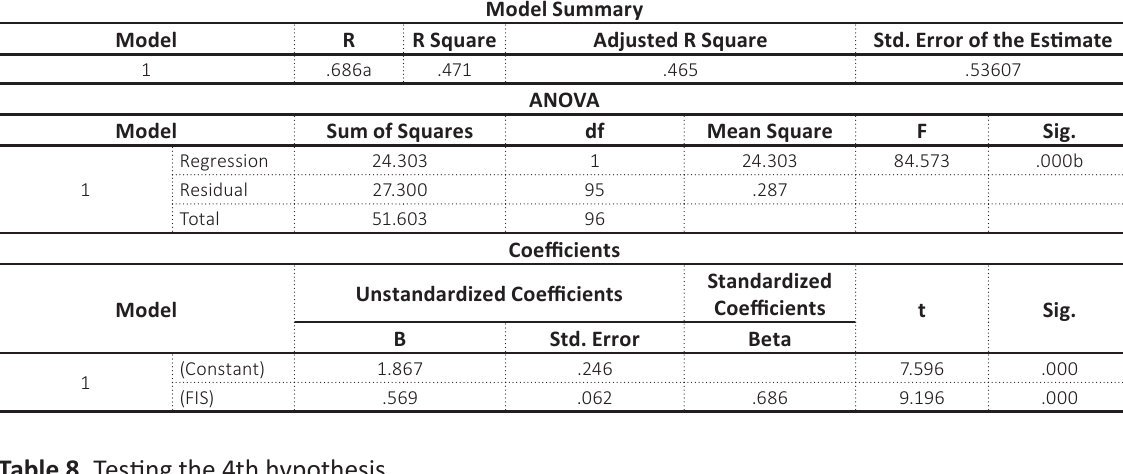
Table 8. Testing the 4th hypothesis